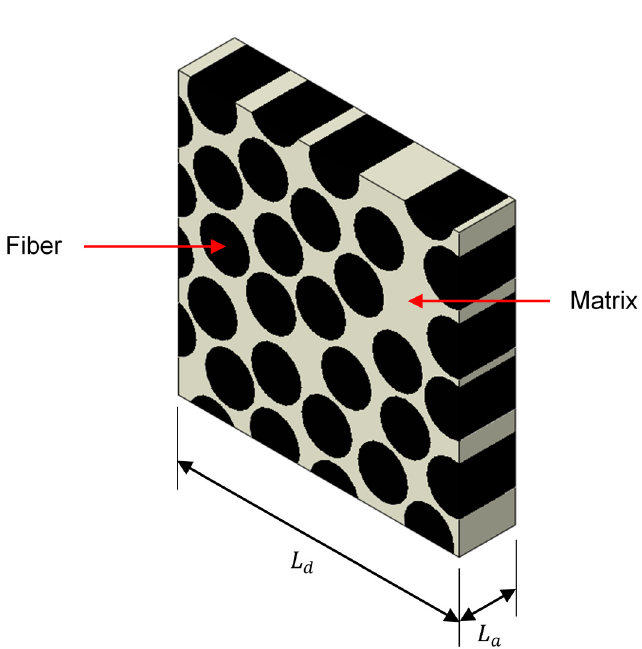
Figure 1. Example of a